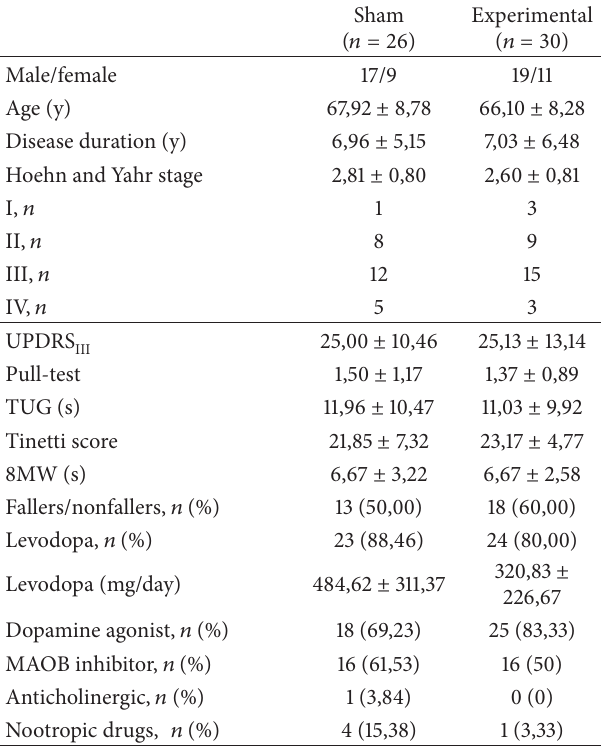
Table 1: Demographics and clinical scores of patients at